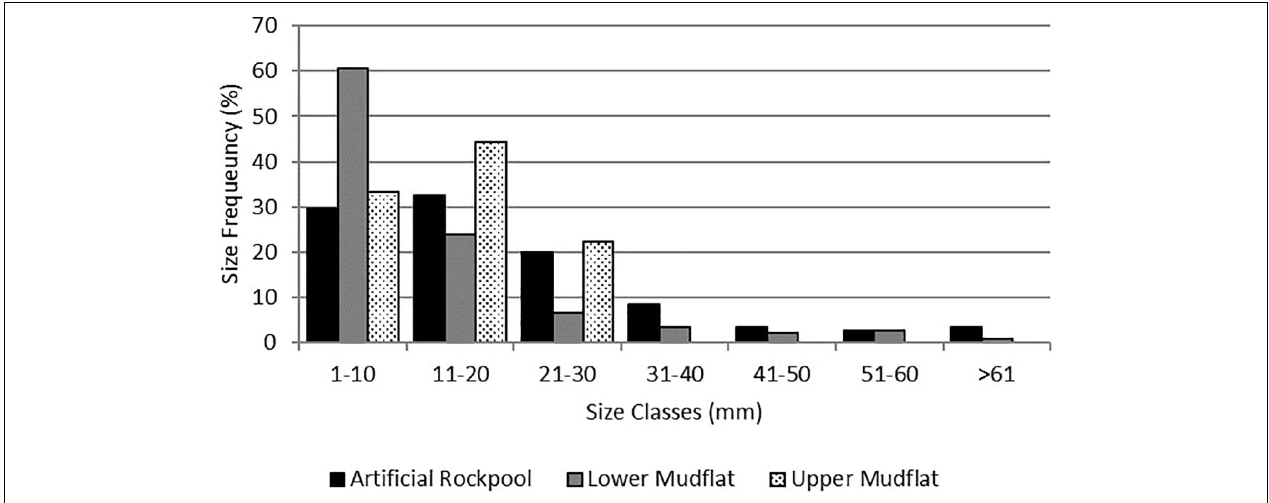
FIGURE 6 | Size frequency (total length) of the ragworm Hediste diversicolor (Müller, 1776) in the artificial rockpools ( n = 153), lower mudflat ( n = 164), and upper mudflat ( n = 10).